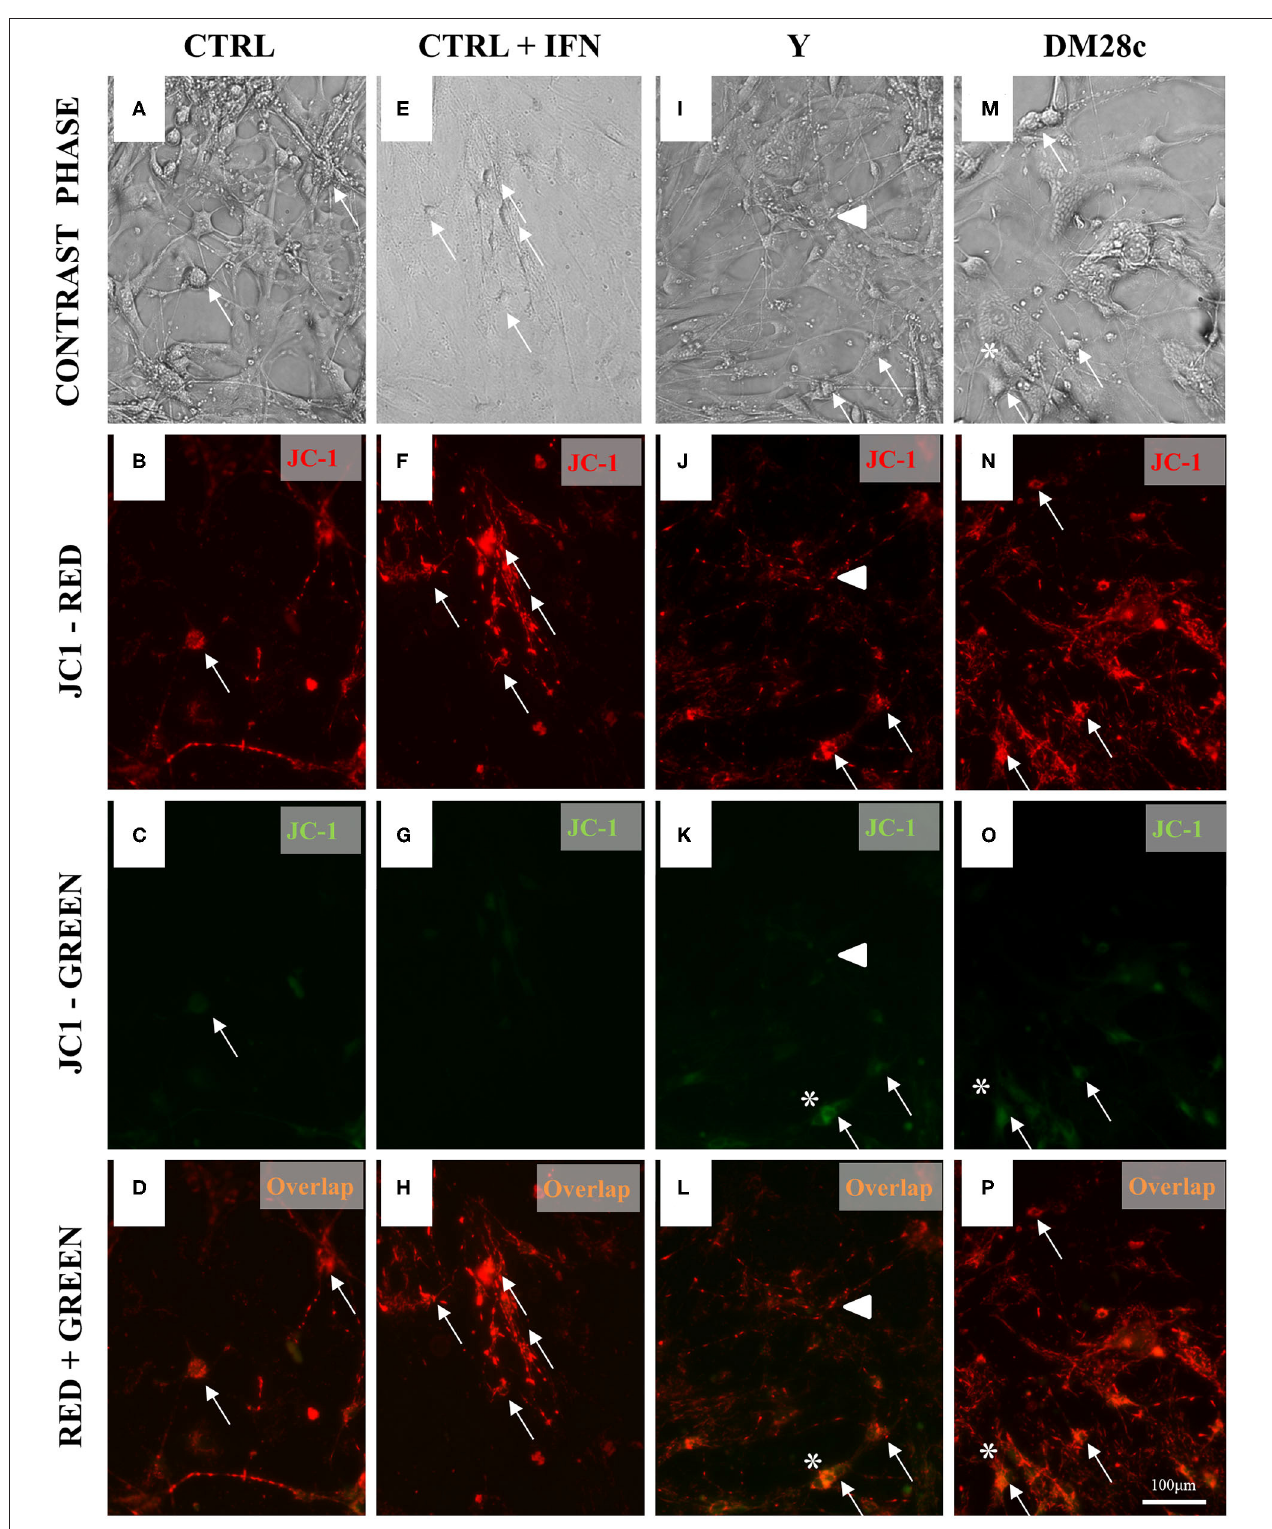
FIGURE 6 | Increased mitochondrial depolarization in myenteric neurons infected with the Y and Dm28c strains of T. cruzi . Neurons removed from the myenteric plexus were dissociated, plated, and infected or not with T. cruzi strains Y and Dm28c trypomastigotes for 72h. Then, the coverslips were washed and exposed